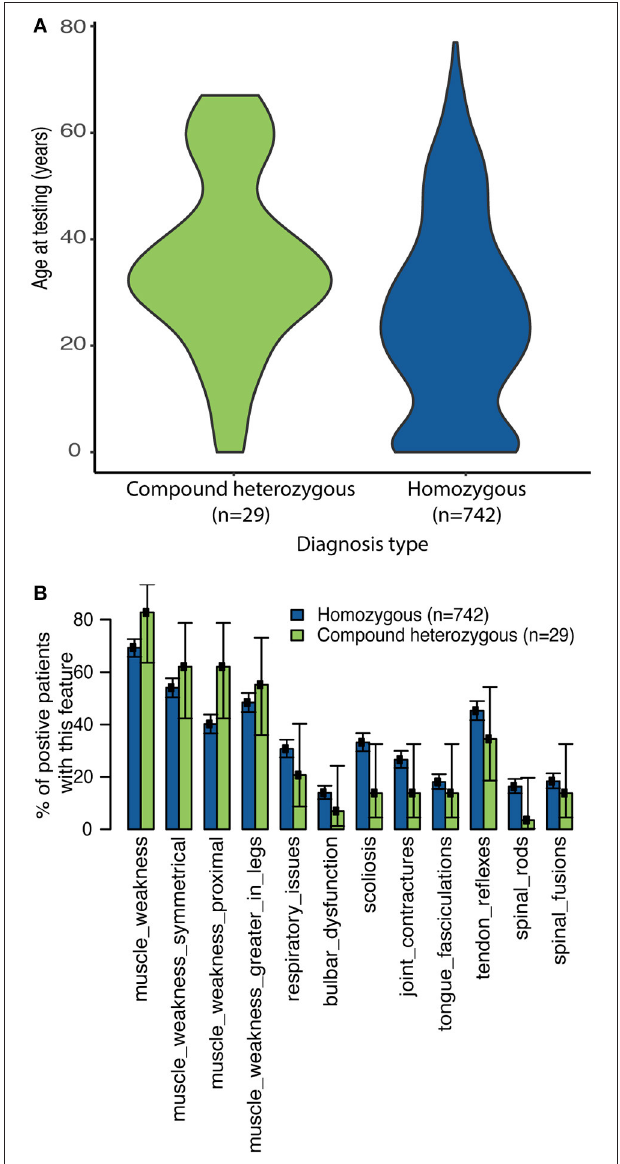
FIGURE 2 | Clinician-reported clinical features among diagnostic and nearly diagnostic individuals tested through SMA Identified. (A) Violin plots reporting age at time of testing based on genotype. (B) The proportion of individuals with homozygous SMN1 deletion or a single SMN1 deletion plus either a P/LP variant or VUS on SMN1 or SMN2 who reported each clinical feature (as reported by the clinician) was calculated. 95% confidence intervals reported.